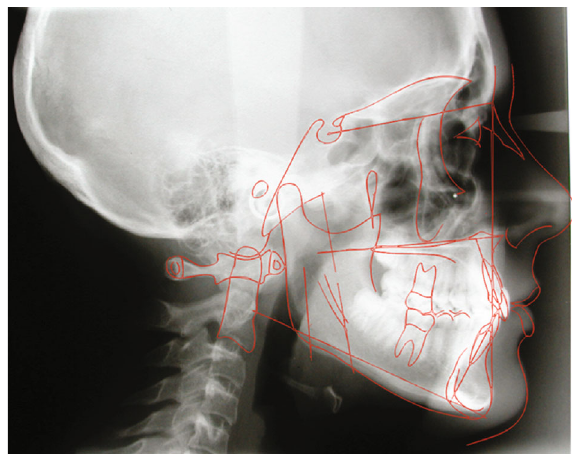
Figure 7: Final lateral cephalogram. Table 2: Cephalometric values at the end of treatment.